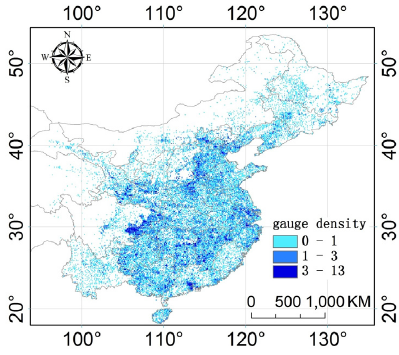
Figure 1. The study area and the locations of the rain gauges during the warm season.